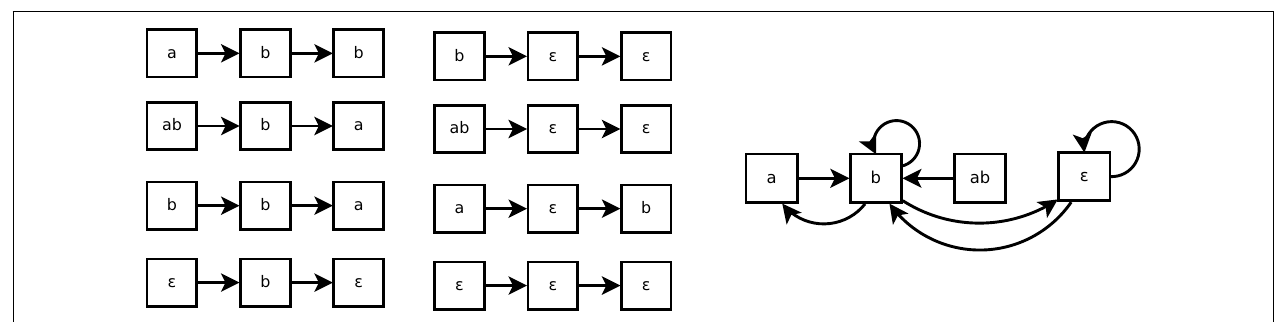
FIGURE 3 | Eight traces of executions of the system of Example 4 (left) and the corresponding state transitions diagram (right)